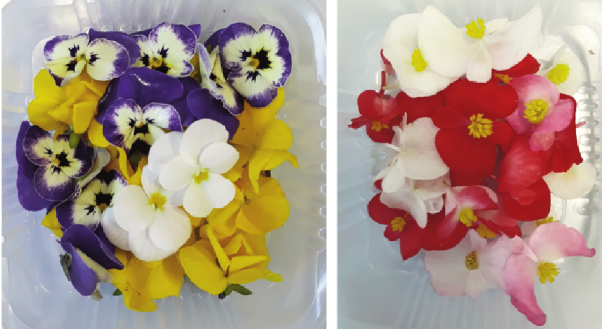
Fig. 1 ­ Flowers of V. cornuta (A) and B. semperflorens (B) freshly harvested and put in the plastic